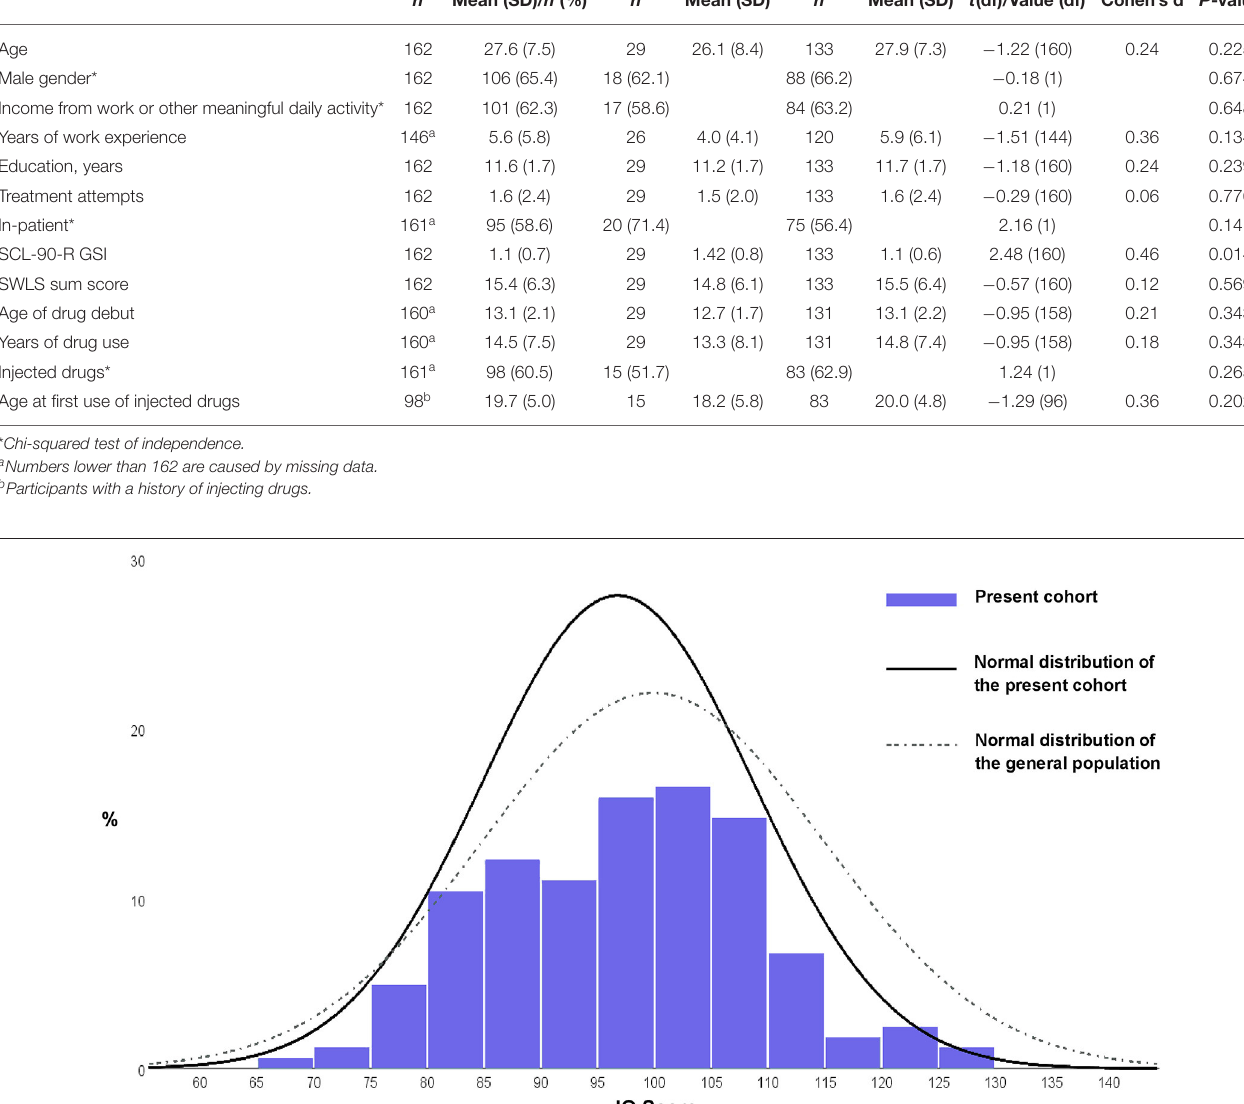
(SD = 3.8, 95% CI = 78.8–81.7), whereas the mean WASI FSIQ was 100.8 (SD = 9.4, 95% CI = 99.1–102.4) in the non-BIF